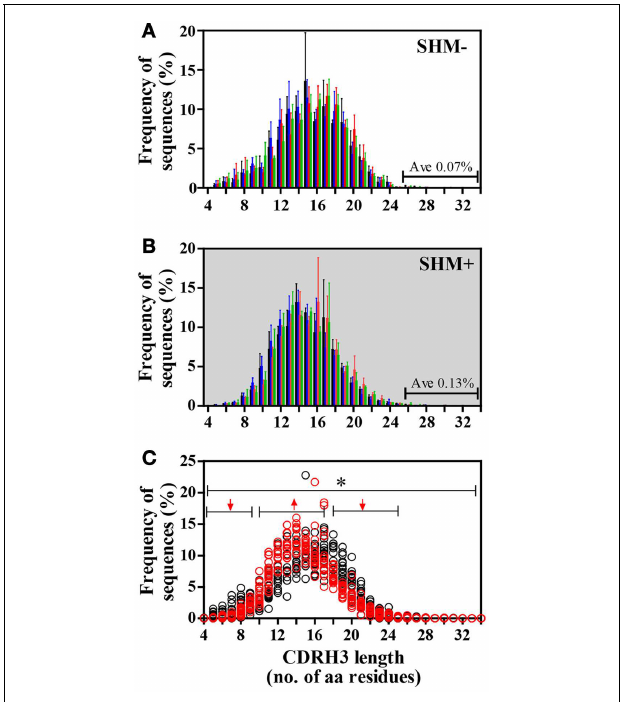
FIGURE 4 | Frequency distribution of IGHM CDRH3 amino acid lengths differed between IgM B cells without or with SHM . (A) Lengths of SHM − CDRH3 regions displayed a Gaussian distribution ranging from 4 to 31 amino acid residues; lengths of 15 amino acids occurred most frequently. (B) Lengths of SHM + CDRH3 regions showed Gaussian distribution ranging from 5 to 34 amino acids with lengths of 14 amino acids used most often. (C) Overall length distribution between SHM − and SHM + sequences differed [* p = 0.004]. Among SHM + sequences, shorter lengths [4–9 amino acids] and longer lengths [18–25 amino acids] were expressed significantly less [ ↓ , p < 0.0001], while lengths of 10–17 amino acids were used more frequently in comparison to SHM − sequences [ ↑ , p < 0.0001]. Bars: HC, black; SLE, blue; HIV-infected individuals: